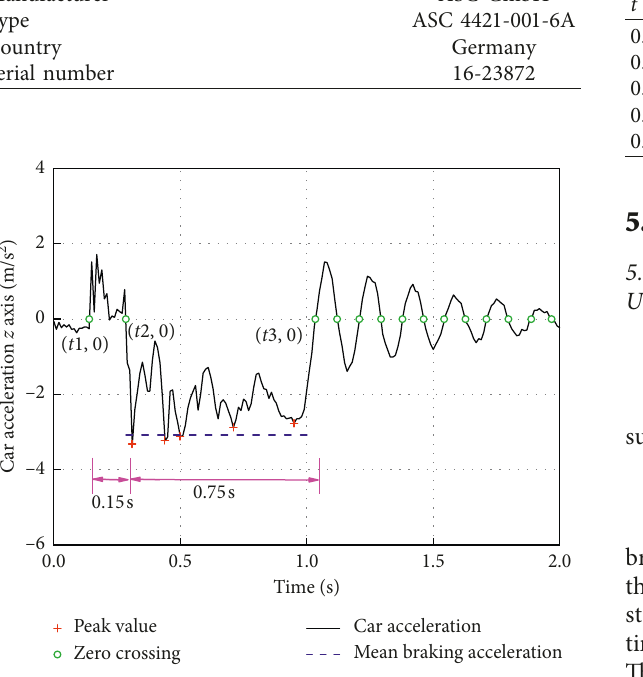
Figure 7: Acceleration test results of unloaded uplink emergency braking.